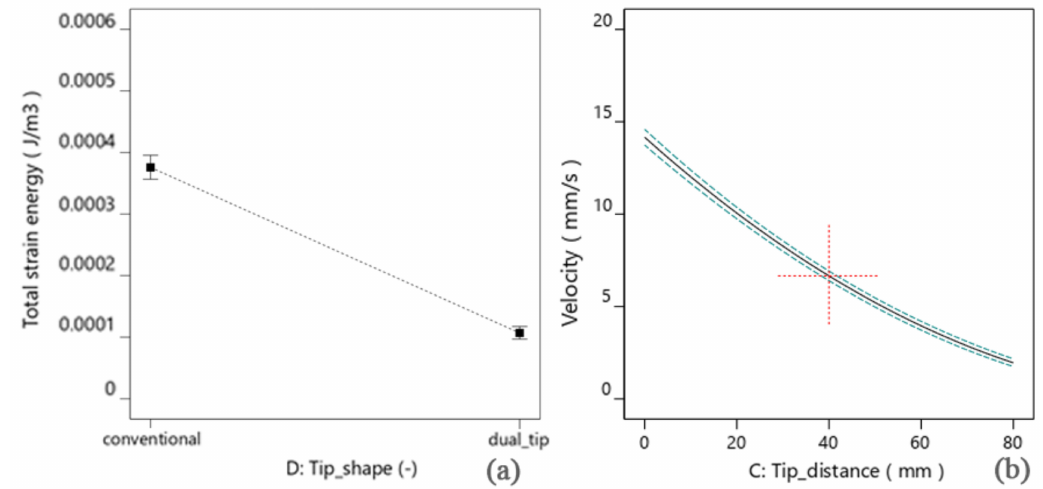
Figure 8. E ff ects of tip distance on total strain energy ( a ) and wave propagation velocity ( b ).